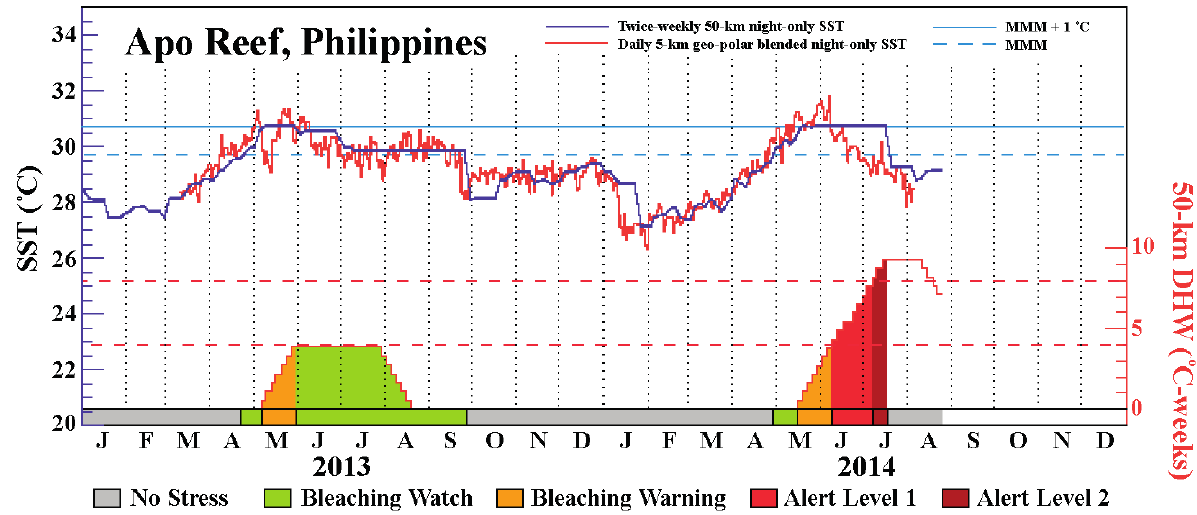
Figure 4. CRW’s twice-weekly, 50-km, night-only SST (purple line) from a 50-km pixel near Apo Reef, Philippines (see arrows in Figure 5c,d), overlaid with the daily, 5-km, night-only SST (red line) from a 5-km pixel located at the center of the 50-km pixel, for January, 2013–August, 2014. The lower portion of the graph shows the twice-weekly, 50-km DHW and bleaching stress levels (colored polygons). The flat portions of the purple 50-km SST time series indicate periods with no SST update. The persistent data gap during May–July 2014, caused the 50-km DHW product to overestimate the accumulated thermal